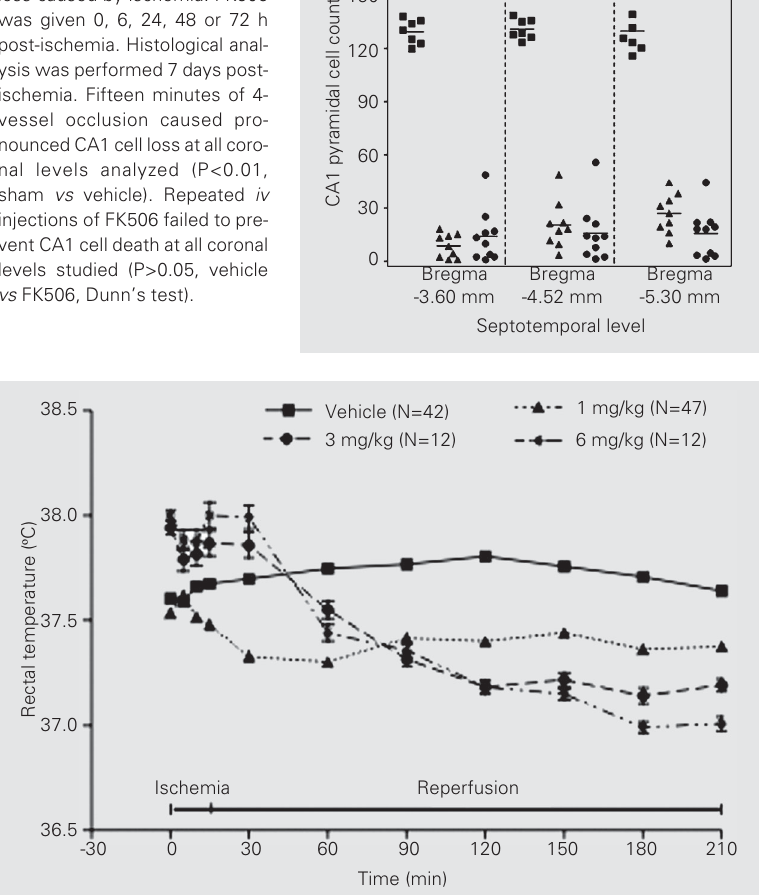
Figure 5. Change in rectal temperature (mean ± SEM) of rats subjected to cerebral ischemia and treated with vehicle or FK506. The groups receiving vehicle or FK506 (1 mg/kg) in the three experiments were pooled, since rectal temperature was measured under the same treatment conditions. FK506 significantly reduced rectal temperature at all doses compared to the group receiving vehicle alone (P<0.05-0.001, Newman-Keuls test). However, this effect did not alter the degree of normothermia (37-38